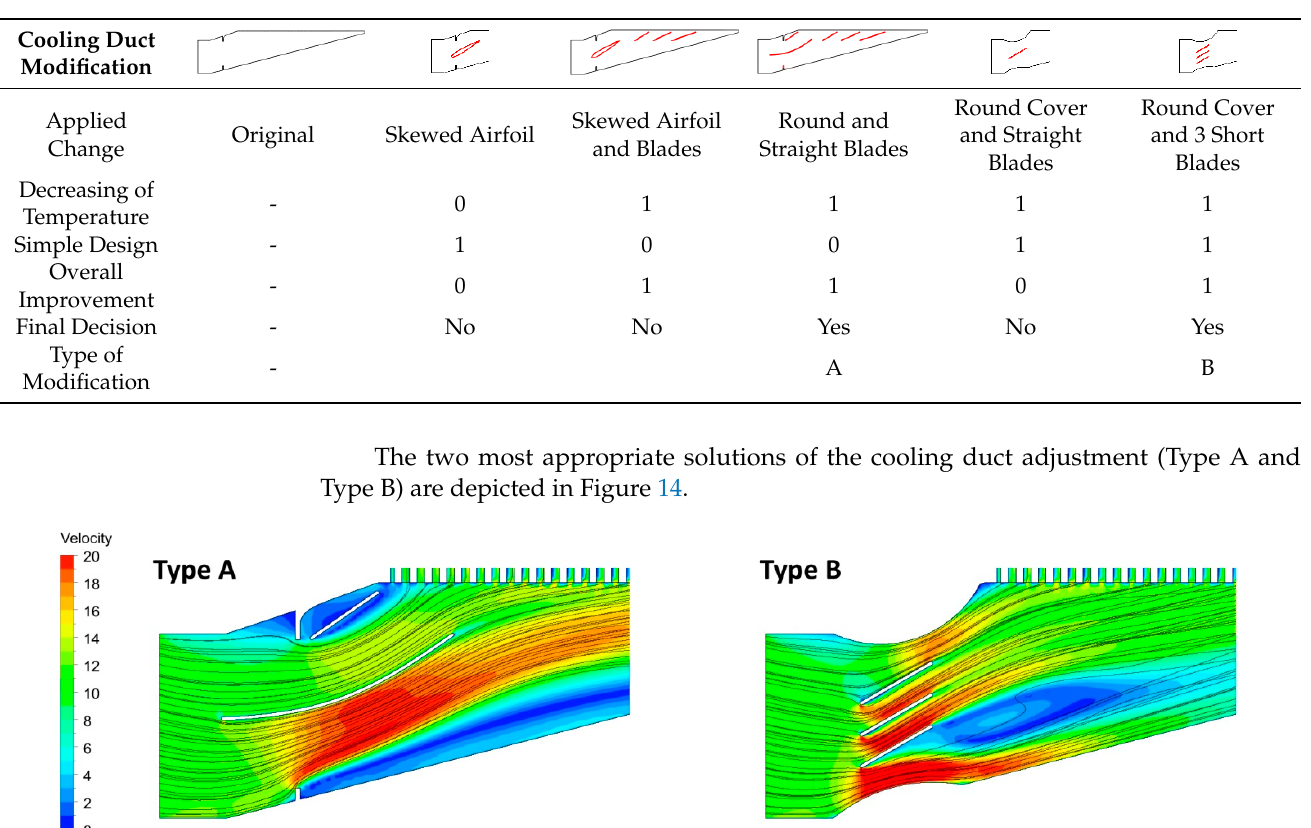
Table 3. Analyzed modification of the cooling duct of PEMFC.